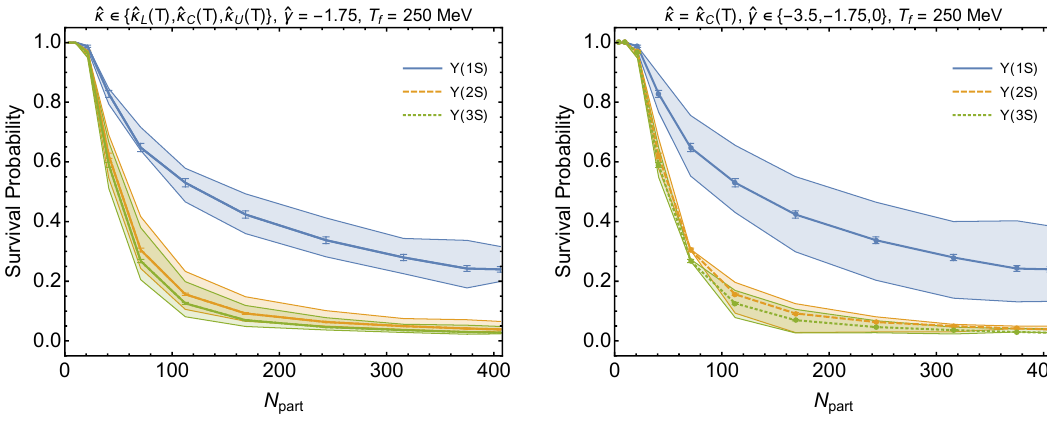
Figure 6 . Survival probability of S -wave bottomonium states versus N part using Gaussian initial conditions to regularize the delta function. In the left panel, the shaded bands show the change in the prediction for survival probability of S -wave states when varying ˆ κ ∈ { ˆ κ L ( T ) , ˆ κ C ( T ) , ˆ κ U ( T ) } , while assuming ˆ γ = − 1 . 75 . In the right panel, the shaded bands are obtained by varying ˆ γ ∈ {− 3 . 5 , − 1 . 75 , 0 } while assuming ˆ κ = ˆ κ C ( T ) . The error bars on the central lines indicate the statistical uncertainty associated with the average over the quantum